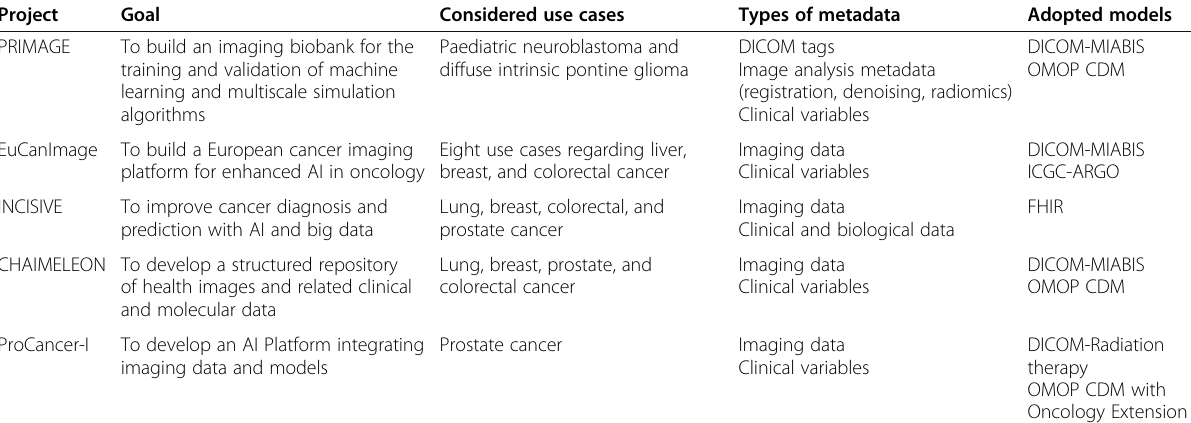
Table 2 Summary of the AI4HI projects, listing their goals, use-cases, types of metadata identified so far